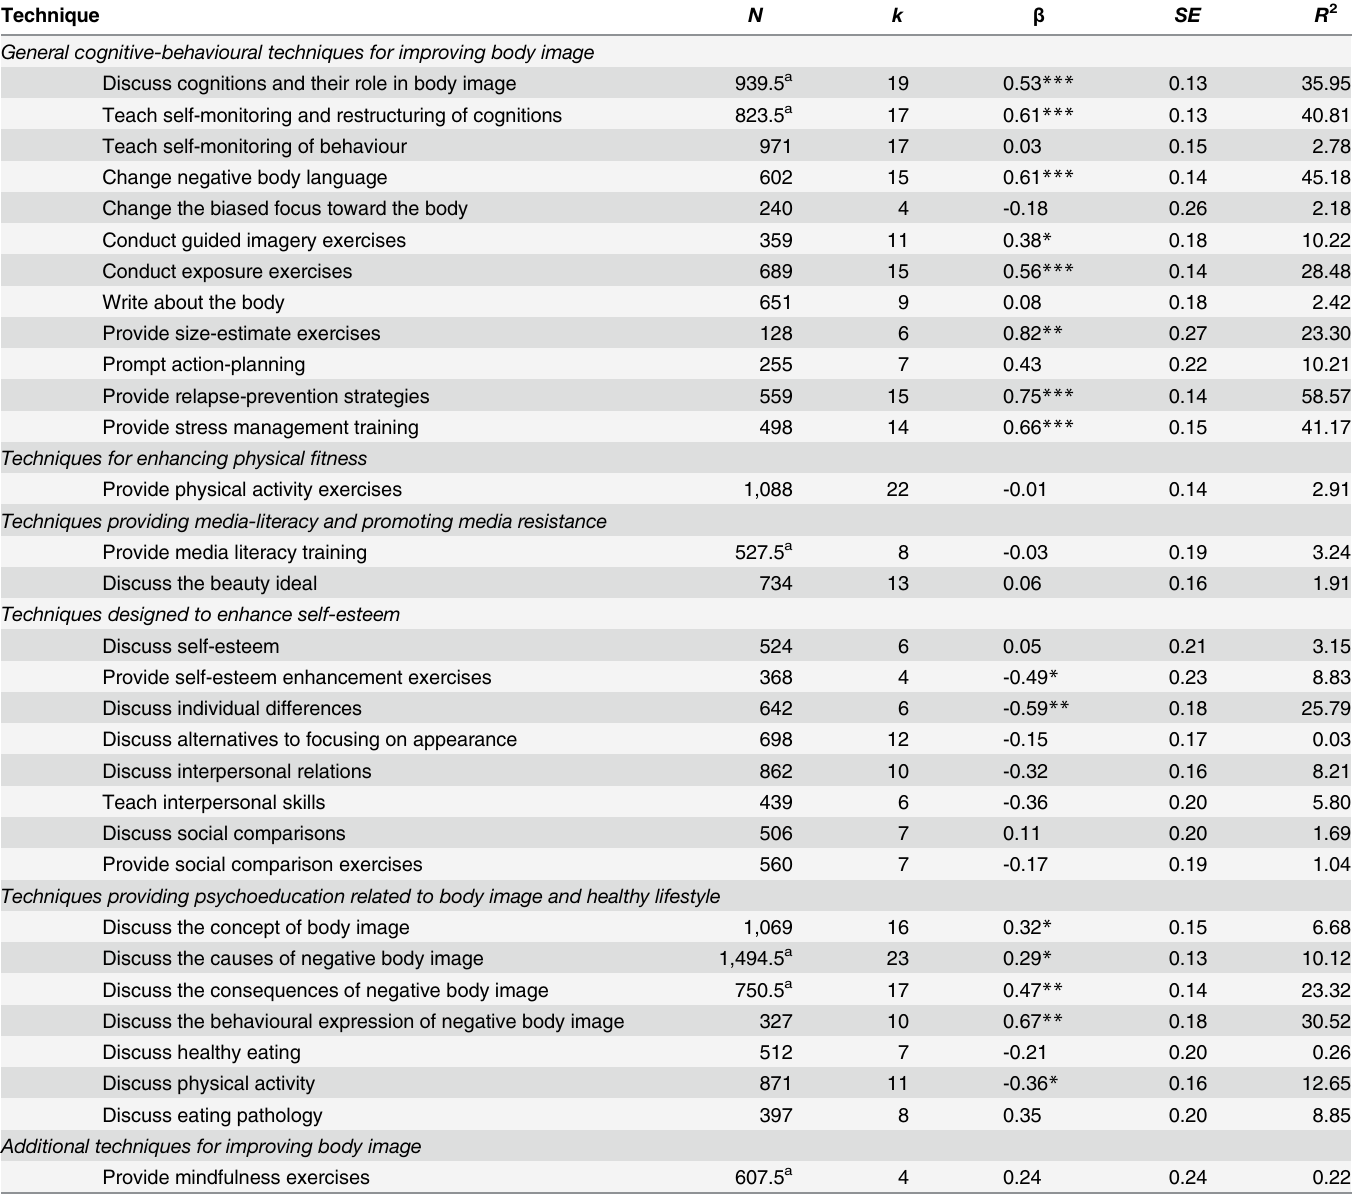
Table 5. Effect of Specific Change Techniques on Body